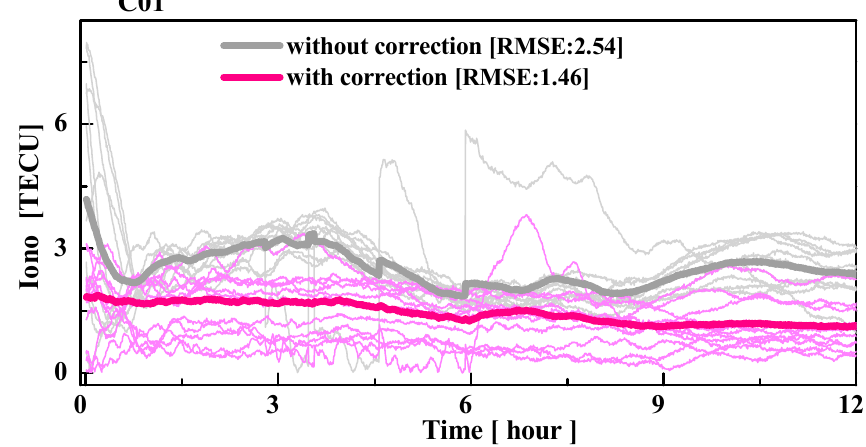
Figure 8. Time series of the ionospheric residual at the CUT0 station of C01 from DOY 46 to 66 in 2017 (16 February 2017 to 7 March 2017). The grey and red lines represent the ionospheric residuals without and with multipath correction, respectively. The thin and bold lines represent each arc and average values, respectively. Table 2. Root mean square error (RMSE) of the ionospheric residual without and with the corrections of multipath error.